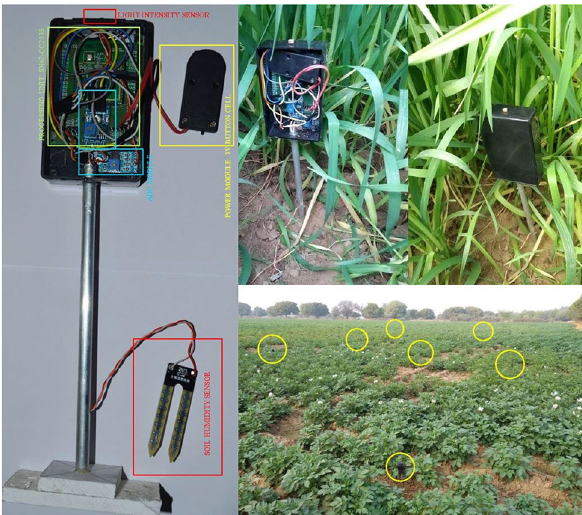
Figure 1. Sensor node prototype and deployment in T wheat and T potato